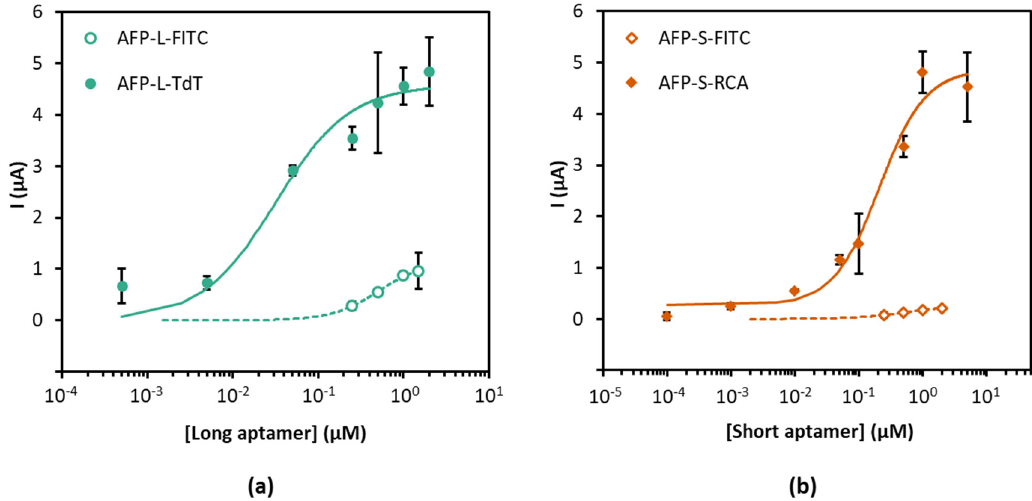
Figure 4. ( a ) Binding curves obtained on AFP-modified magnetic beads with the long aptamer without (open circles) and with (solid circles) TdT amplification. ( b ) Binding curves obtained on AFP-modified magnetic beads with the short aptamer without (open diamonds) and with RCA amplification (solid diamonds).